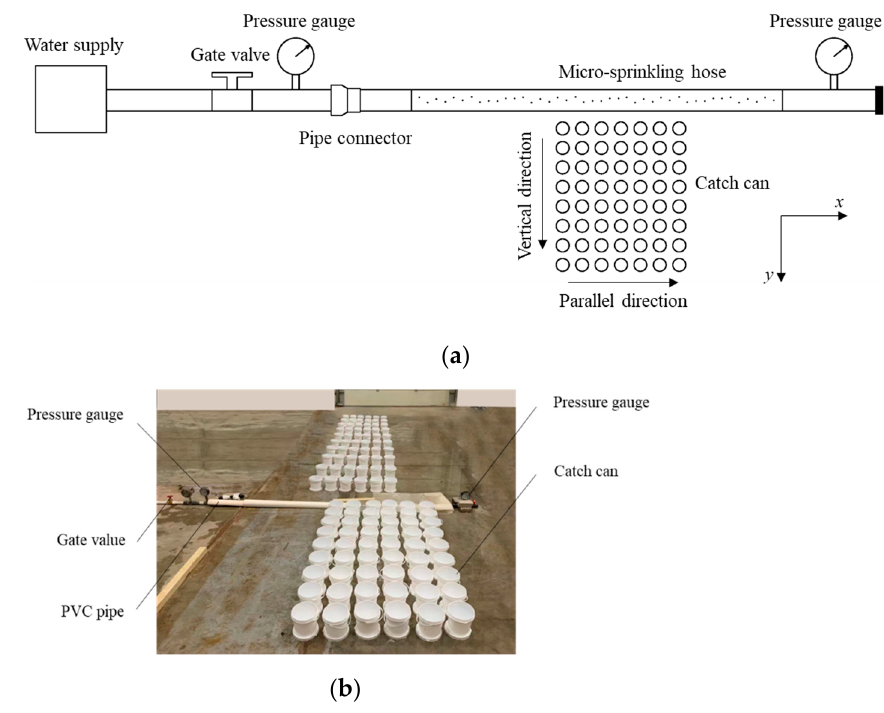
Figure 3. The experimental setup in ( a ) schematic diagram and ( b ) physical map.